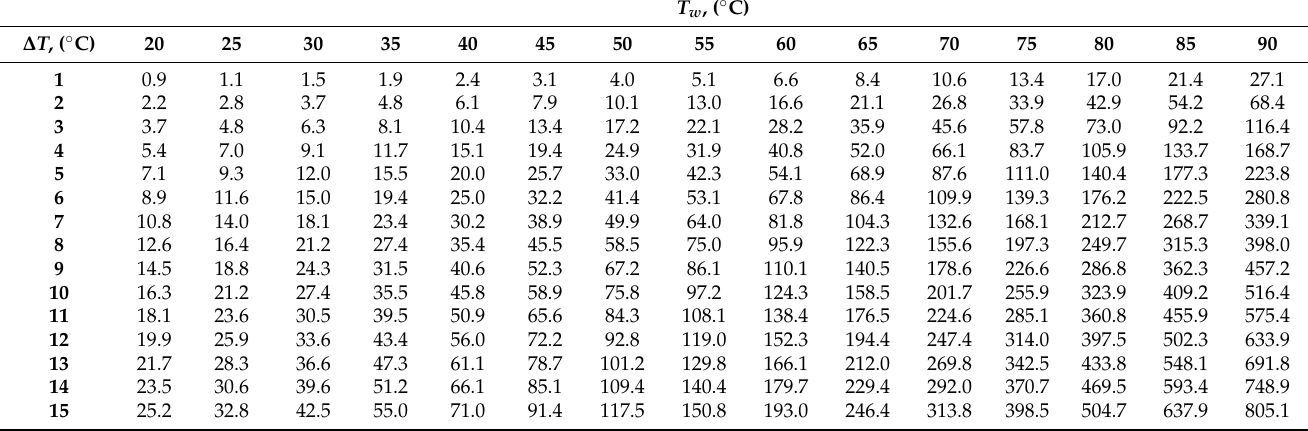
Table 7. The evaporation rate of water (mg/s/m 2 ) in the function of the temperature of the water and the temperature difference between water and